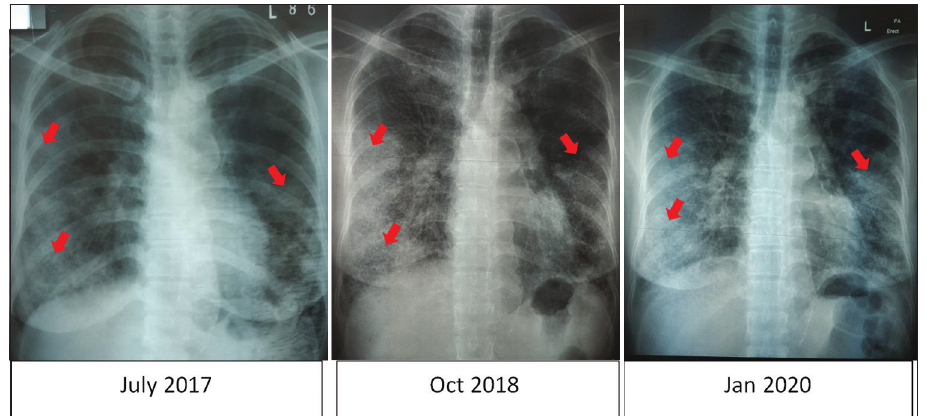
FIGURE 1. The serial chest X-ray showed bilateral symmetrical consolidation (red arrows) with predominance in the peripheral, perihilar, and basal area.